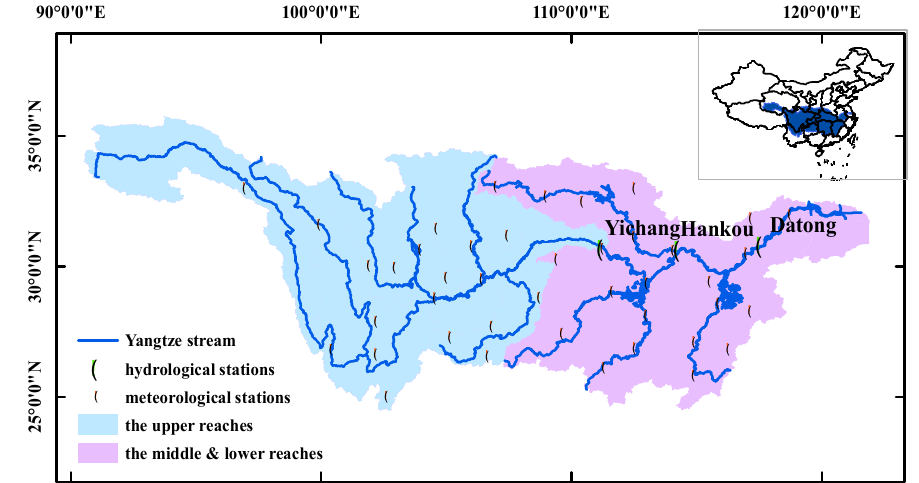
Figure 1. River networks of the Yangtze River (YR) basin. Stream gauging stations and meteorological stations are marked.